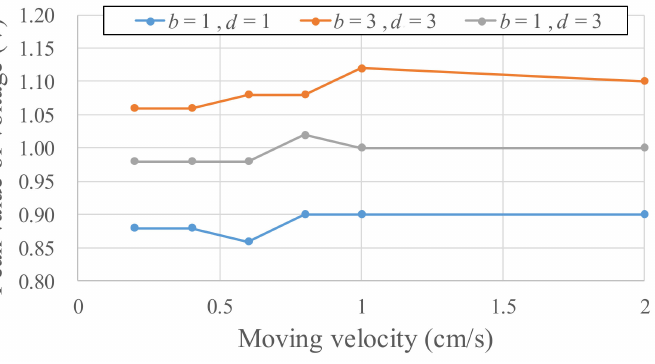
Figure 8. Output voltages of the Wiegand wire under different magnetic field